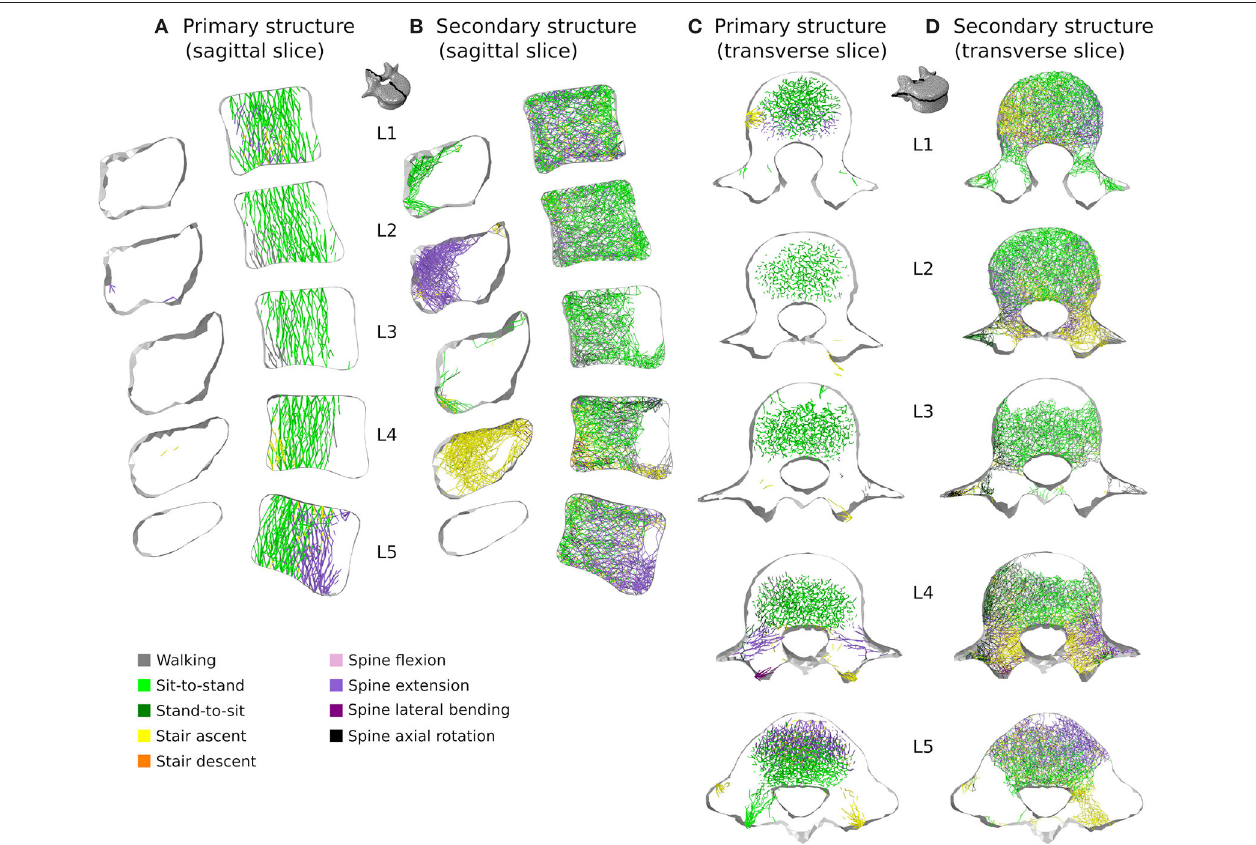
FIGURE 11 | 3 mm mid-sagittal (XY plane) and through-processes transverse (XZ plane) slices of the converged models in the sedentary scenario, showing a map of which activity gives rise to the highest absolute maximum axial strain for the adaptation of the trabecular truss elements of the primary (A,C) and secondary (B,D) structures. Cortical shell elements are shown in light